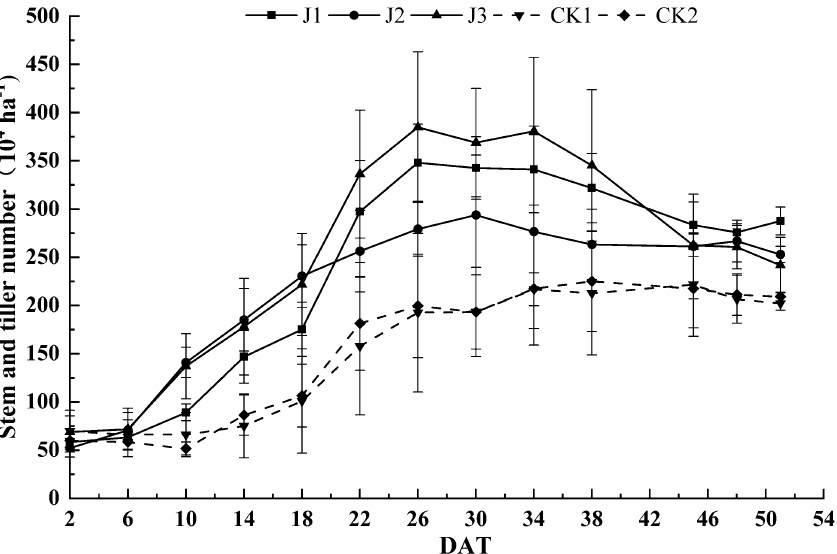
Figure 4. Rice stem and tiller numbers under the applied fertilization methods. The error bars show the standard error ( n =